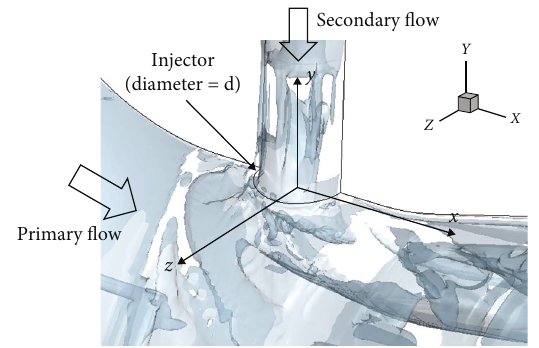
Figure 8: Vortex structure near the injector, Liutex magnitude = 5000 .